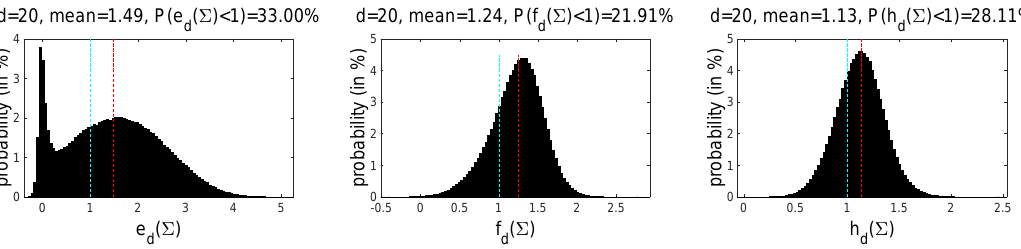
Figure 5: Histograms of the probability distributions of ˜ e 20 ( Σ ) (left), ˜ f 20 ( Σ ) (middle) and ˜ h 20 ( Σ ) (right) with Σ being the covari- ance matrix of 20 randomly chosen CDS upfront time series out of the 395 considered entities. The vertical, red lines give the respective mean, and the blue lines represent again the border 1 between over- and underrepresentation of non-central